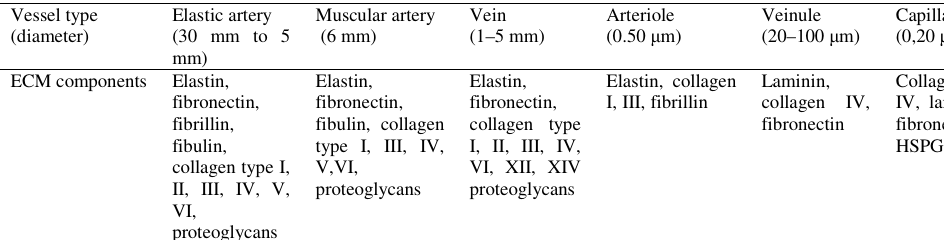
ECM, extracellular matrix; HSPG, heparin sulfate proteoglycan.